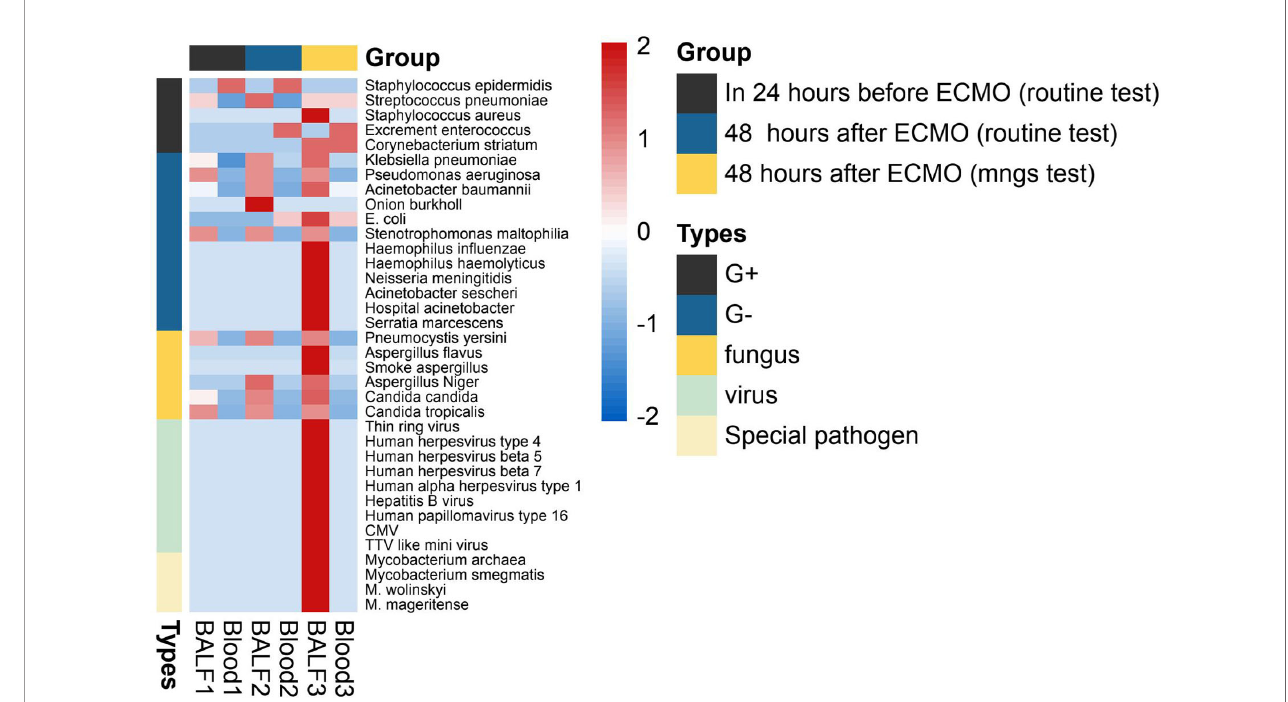
FIGURE 3 | The heatmap of the pathogen species and strains detected by mNGS (within 48 h after ECMO) or routine test (24 h before and within 48 h after ECMO). The value of each pathogen represents the number of times detected in this group; after log10 conversion, the value is used for visual display. The pathogen was divided into fi ve